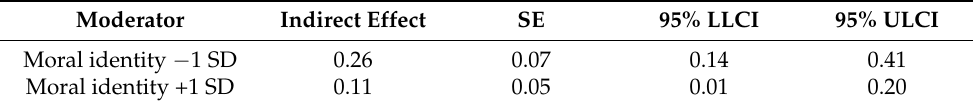
Table 6. Results of indirect and conditional indirect effect analyses. Moderator Indirect